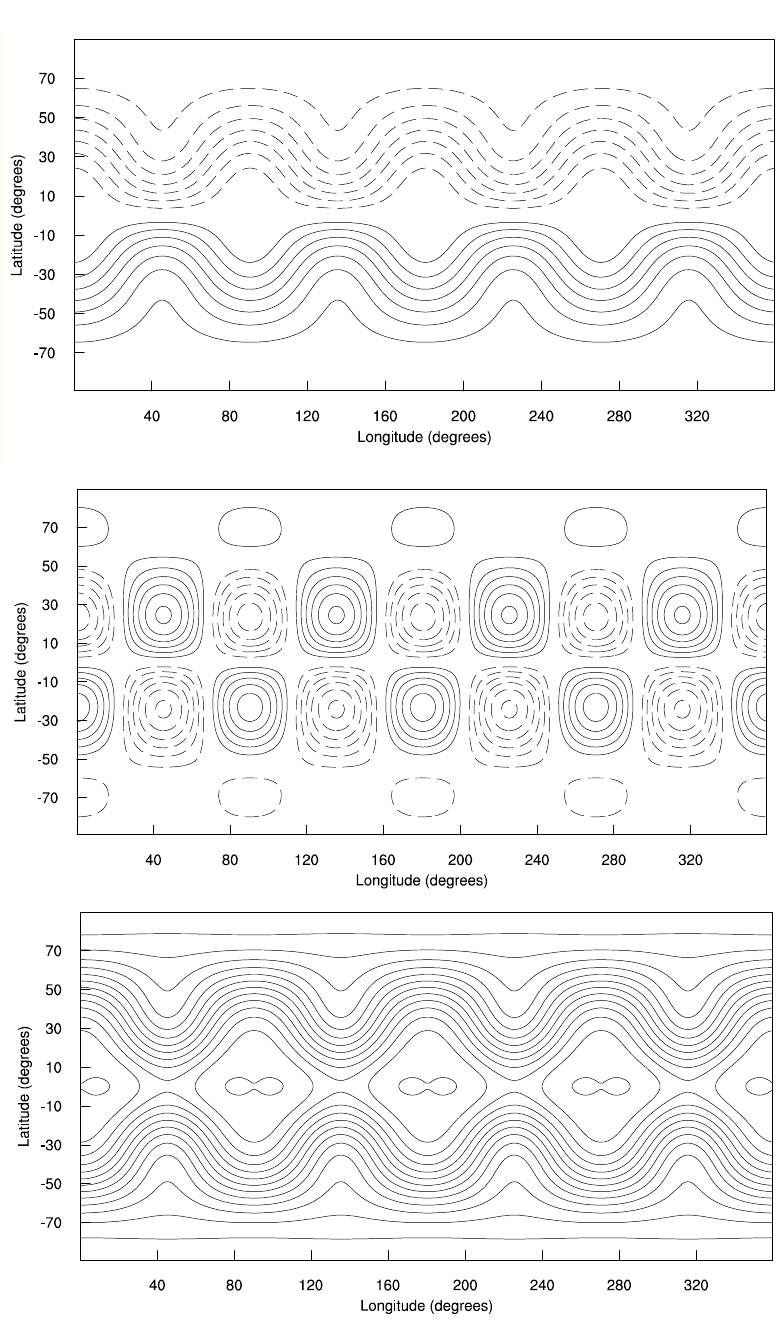
Figure 3. Continuous stream function ( top ), vorticity ( middle ), and fluid depth ( bottom ) at a one-degree resolution. Stream function is in the range of ( − 3 × 10 8 , 3 × 10 8 ), vorticity in ( − 6 × 10 − 5 , 6 × 10 − 5 ), and depth in (600,3000) .